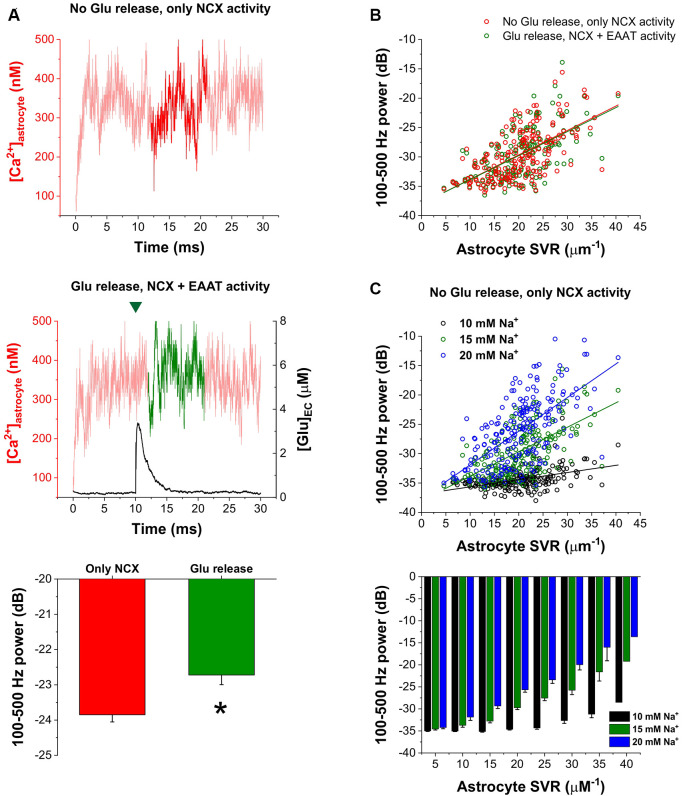
Increased astrocytic Na+ concentration enhances astrocytic Ca2+ oscillations. (A) Representative traces of astrocytic Ca2+ concentration in the astrocytic processes surrounding a synapse with high SVR (22.4 μm−1). Dark traces represent the analyzed period during which 100–500 Hz power was calculated when no glutamate release occurred and only NCX activity was allowed (top) or when 5,000 molecules of glutamate were released at 10 ms. The green mark indicates the release event (middle). Power of the 100–500 Hz range increased from −23.85 ± 0.20 dB to −22.72 ± 0.27 dB due to synaptic glutamate release in this synapse (n = 5 simulation runs, p = 0.01; asterisk means significant difference, bottom). (B) Correlation of 100–500 Hz powers with astrocytic SVR with (green) and without (red) synaptic glutamate release in the 12–21 ms period in all the investigated 208 synapses. Green and red lines show linear regression fitted to the data (R2 = 0.38 for both lines). (C) Correlation of 100–500 Hz powers with astrocytic SVR at different astrocytic Na+ concentrations in the 12–21 ms period in all the investigated 208 synapses. No glutamate release was initiated, only NCX activity was considered. Black, green and blue lines show linear regression fitted to the data (R2 = 0.20, R2 = 0.38 and R2 = 0.39 respectively; top). Grouping of power vs. astrocyte SVR data shows that increasing astrocytic Na+ concentration enables the emergence of Ca2+ oscillations in thicker processes (bottom).